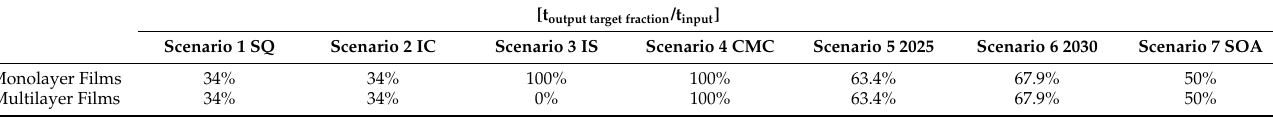
Table 4. Modelled sorting depths of the target fractions for every scenario.